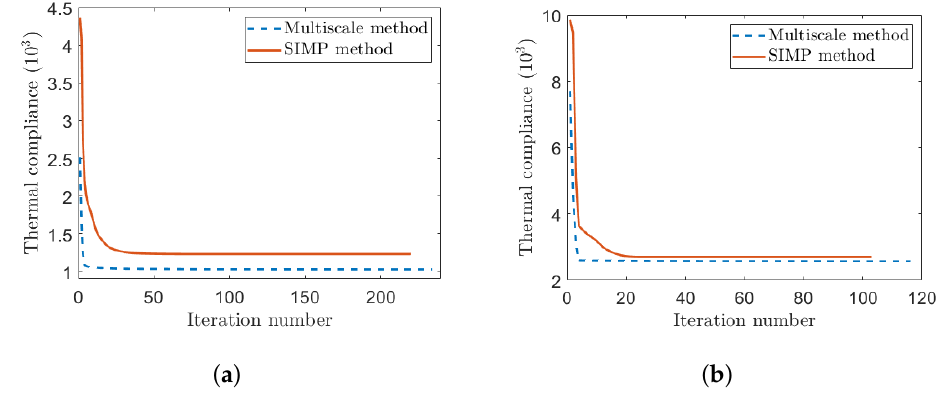
Figure 11. Iteration history: ( a ) compliance convergence history of the SIMP method and the multiscale method for gradient distributed heating; ( b ) compliance convergence history of the SIMP method and the multiscale method for uniform distributed heating